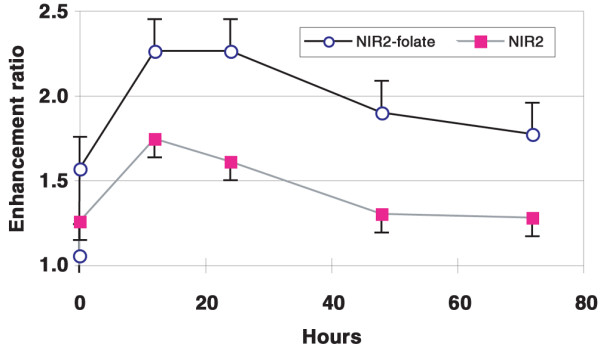
Enhancement ratio of lipopolysaccharide (LPS)-treated inflamed ankles in NIR2-folate (n = 12) and NIR2-free dye (n = 5) injection groups at different time points. A significantly higher enhancement ratio was noted in the NIR2-folate injection group at 24-hour, 48-hour and 72-hour time points (P < 0.05).